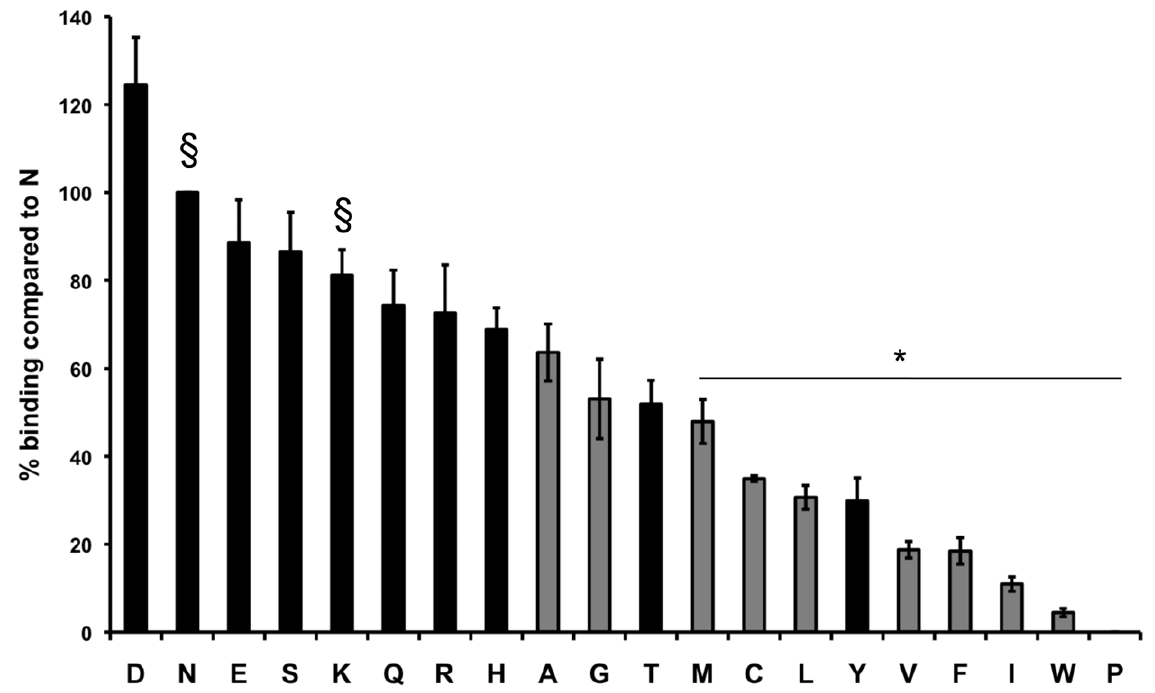
Figure 1. Percentage erythrocyte binding to DBP variants containing single amino acid substitutions at the 417 site. Binding is shown as a percentage compared to the naturally occurring variant N. All constructs are on a Sal I strain background. Polar residues are shown in black. Nonpolar residues are shown in gray. 1 indicates naturally occurring variant containing N or K at the 417 site. * indicates DBP variants which have significantly lower binding than one or both of the naturally occurring residues (N and K) (p , 0.05). Statistical differences were analyzed using a 1-way analysis of variance (ANOVA) and a Tukey’s posttest.